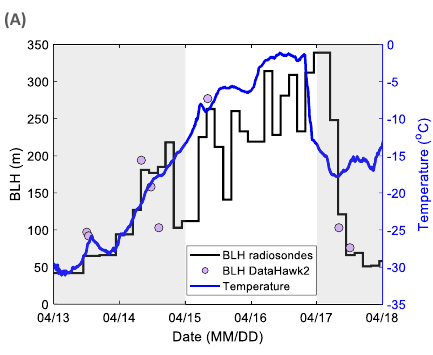
Fig. 1 | Boundary layer height, temperature and particulate matter during the warm air-mass intrusion event. A Evolution of the boundary layer height (BLH, left axis, solid black line and lilac markers) and temperature (right axis, solid blue line), the unshaded area represents the warm air-mass intrusion event and is the